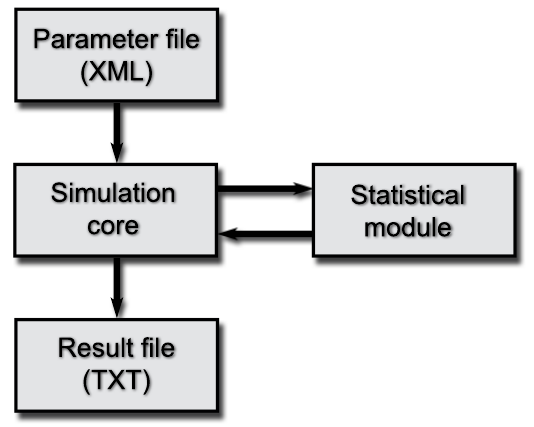
Figure 1: The structure of